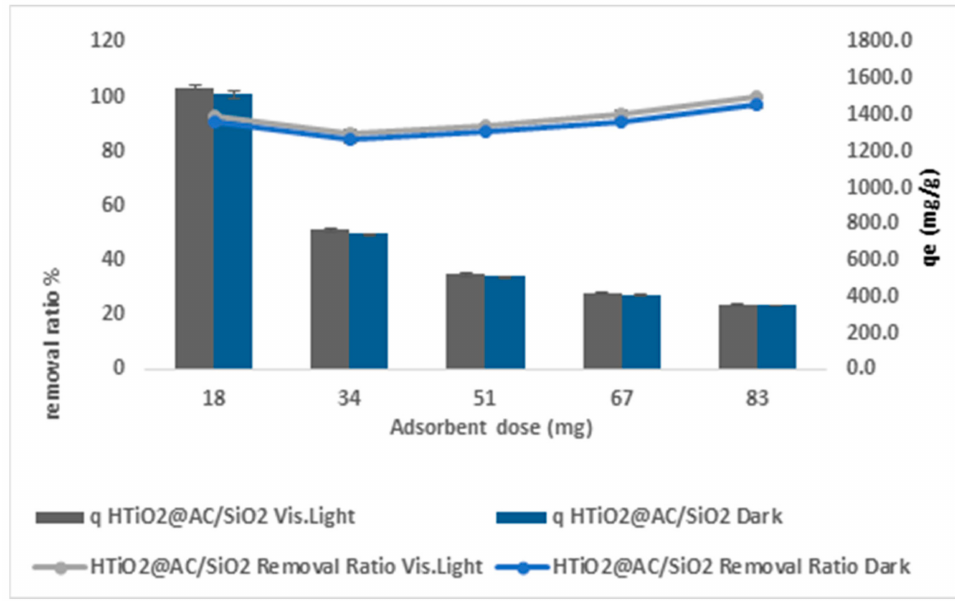
Figure 7. HTiO 2 @AC/SiO 2 doses